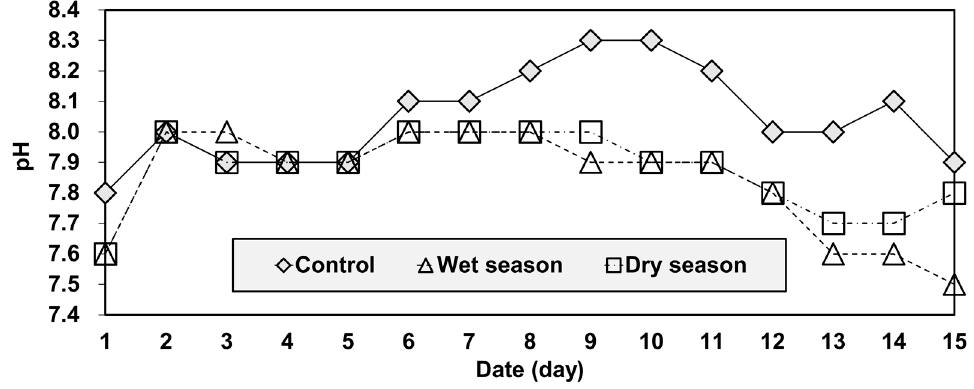
Figure 7. Temporal variations of pH in the reservoir.